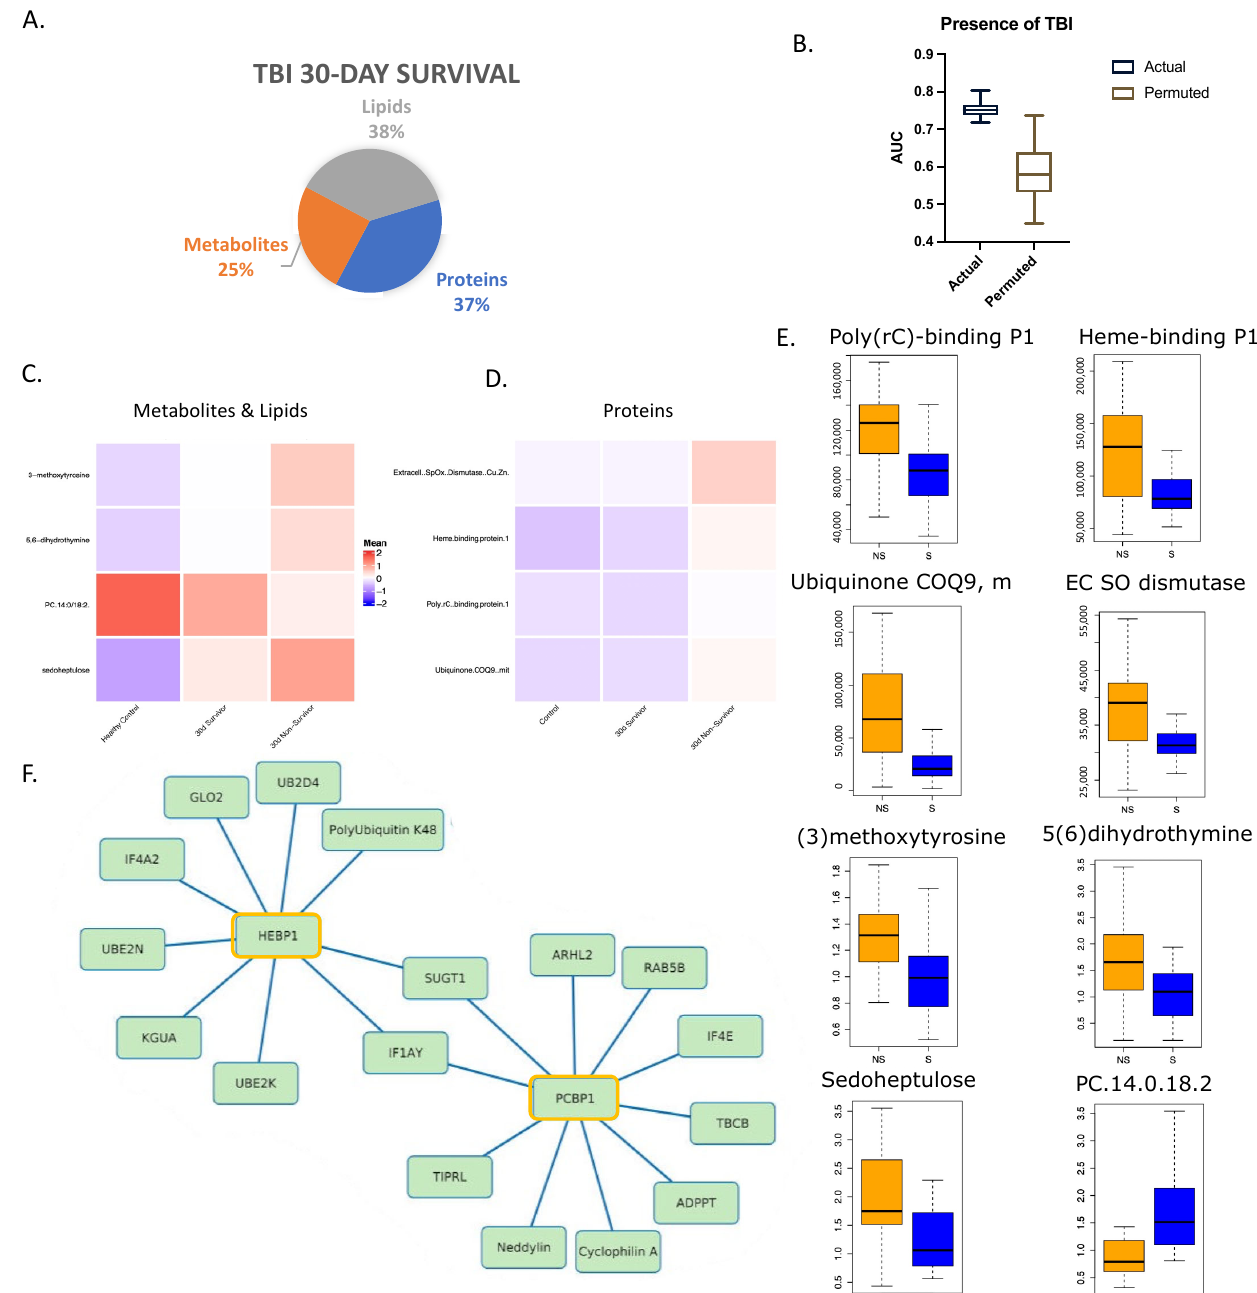
Figure 5. Multi ‐ omic markers predict survival in trauma patients with traumatic brain injury. ( A ) Breakdown of markers from LASSO model output with a total of 8 features. ( B ) Actual and permuted LASSO AUC graph with an AUC of 0.75. ( C ) Heatmap of metabolomic and lipidomic selected features looking at 30 ‐ day survival in patients with TBI only and healthy controls. Healthy controls n = 17, 30 ‐ day survivors n = 27, non ‐ survivors n = 37. ( D ) Heatmap of proteomic features as in ( C ). Low ISS controls n = 29, 30 ‐ day survivors n = 21, non ‐ survivors n = 28. ( E ) Box plots of LASSO ‐ selected features that are significantly different between 30 ‐ day survivors and non ‐ survivors with raw value measurement. ( F ) Correlation network between selected features and proteomic database at Spearman’s r = 0.70 showing direct associations (selected feature outlined in yellow).